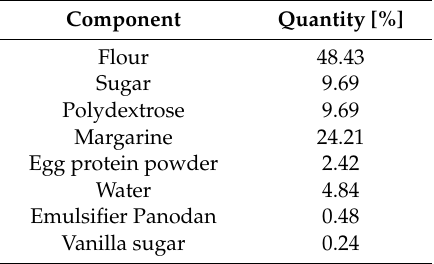
Table 2. Composition of the dough recipe R1 .